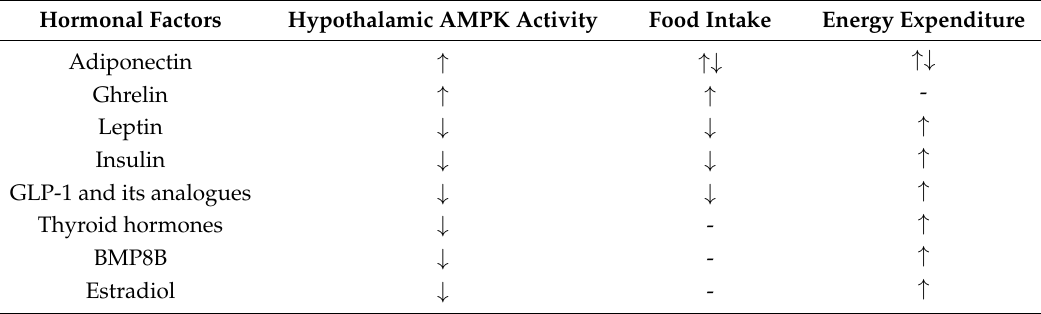
Table 1. Actions of hormonal factors on hypothalamic AMPK activity, food intake, and energy